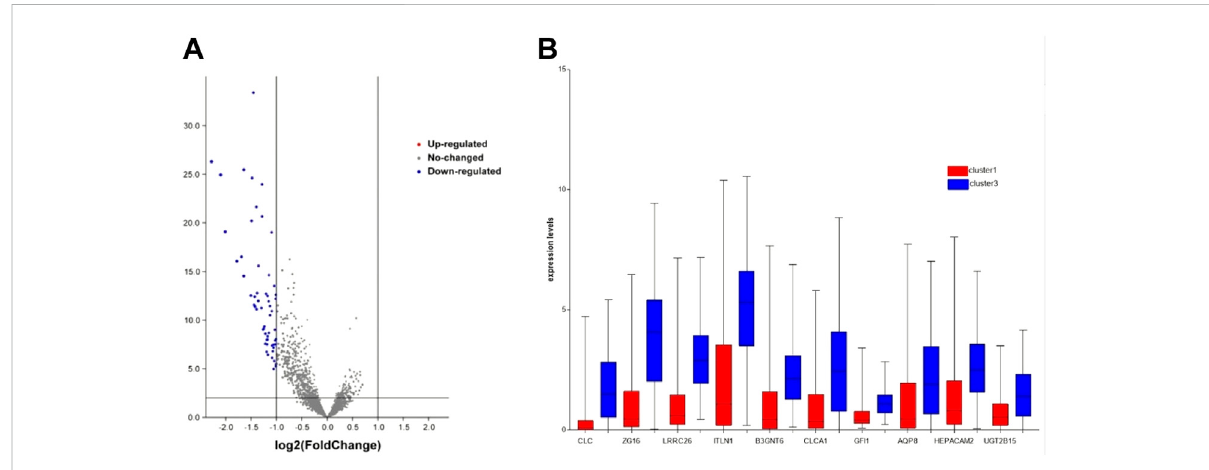
FIGURE 2 DEG ’ s expression between cluster1 and cluster3. (A) DEGs of two clusters via volcano. (B) DEGs with prognostic signi fi cance via boxplot.